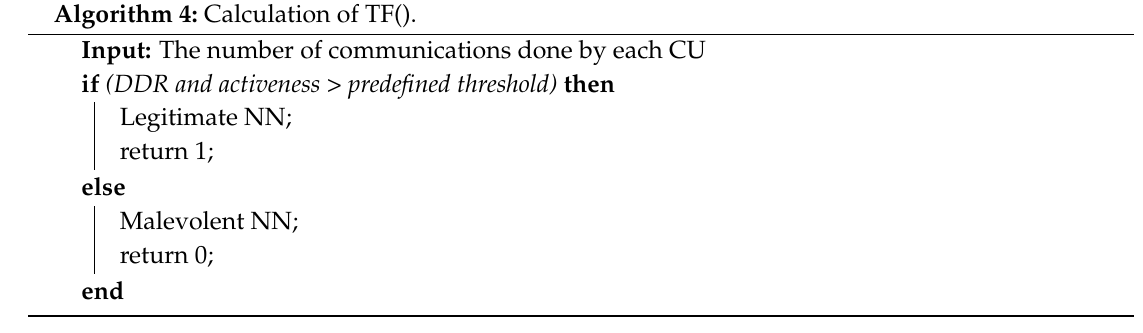
Algorithm 5: Calculation of Level Trust().